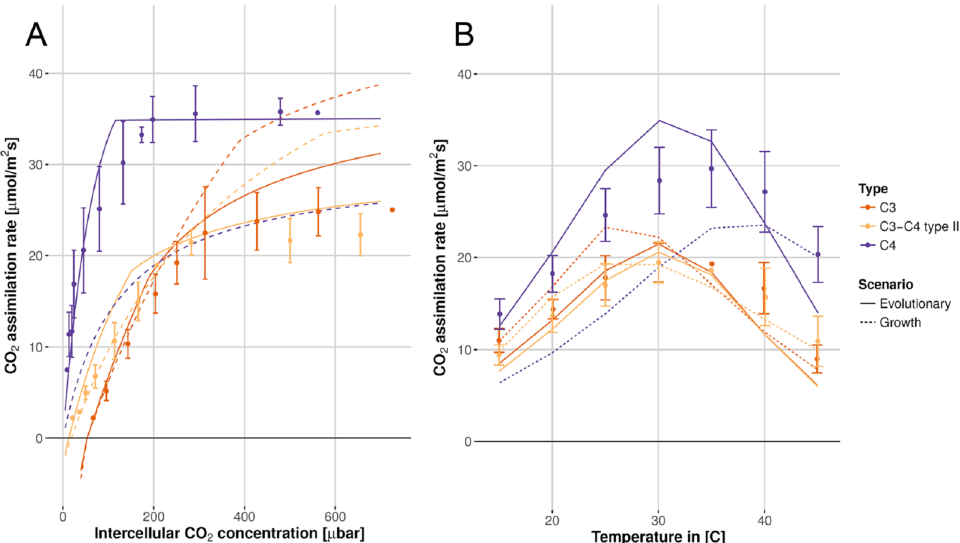
Figure 2. Model results based on optimality in the evolutionary scenario (solid lines) describe the measured data (circles ± SE) better than the model assuming optimal adaptation to the EGC (dashed lines) for F. robusta (C 3 ), F. ramosissima (C 3 –C 4 ), and F. bidentis (C 4 ) grown at the 380 µbar atmospheric CO 2 (data from Vogan and Sage 39 ). ( A ) The net CO 2 assimilation rate as a function of intercellular CO 2 concentration, measured at 30 °C. SE was calculated based on three independently measured plants. ( B ) The net CO 2 assimilation rate as a function of temperature at 380 µbar atmospheric CO 2 concentration. See Supplementary Table S9 for the residual sum of squares. Figure created using R 4.0 52 .